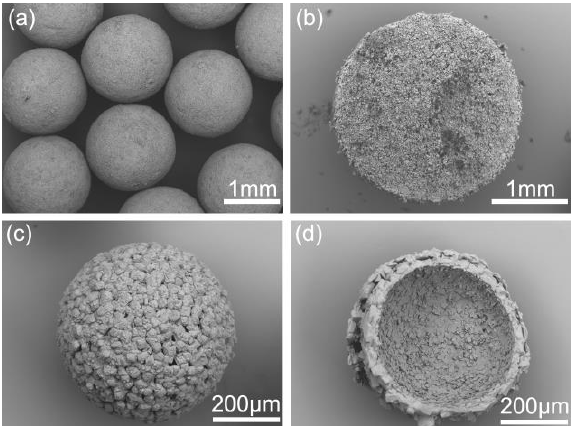
Figure 2. SEM images of different products: ( a ) crystals prepared by the spherical agglomerate (SA) method, ( b ) profile chart of solid sphere particle; ( c ) crystals prepared by the quasi-emulsion solvent diffusion (QESD), ( d ) profile chart of hollow sphere particle.